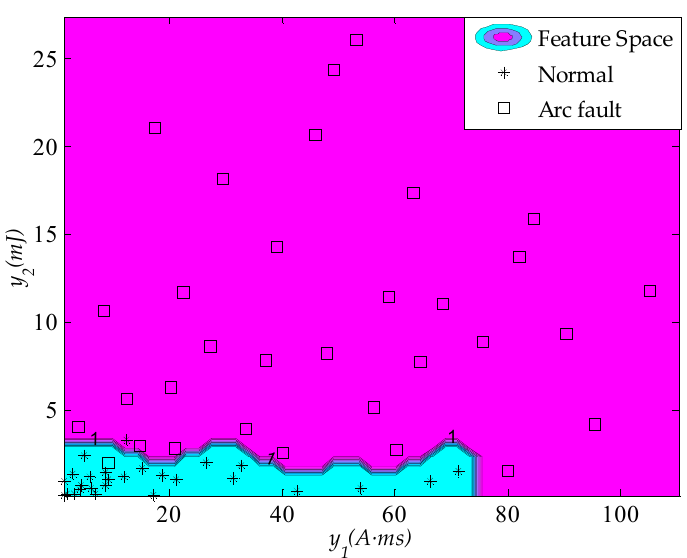
Figure 19. Identification results of load states.